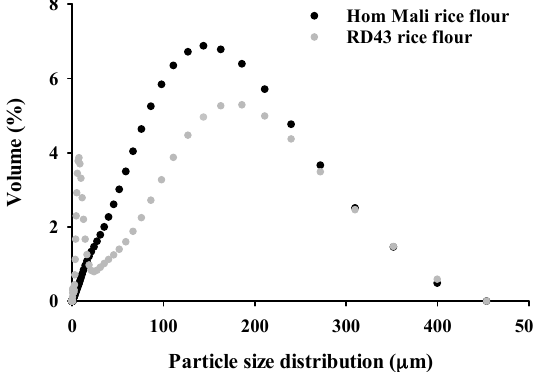
Figure 2. The particle size distribution by volume of rice flour.